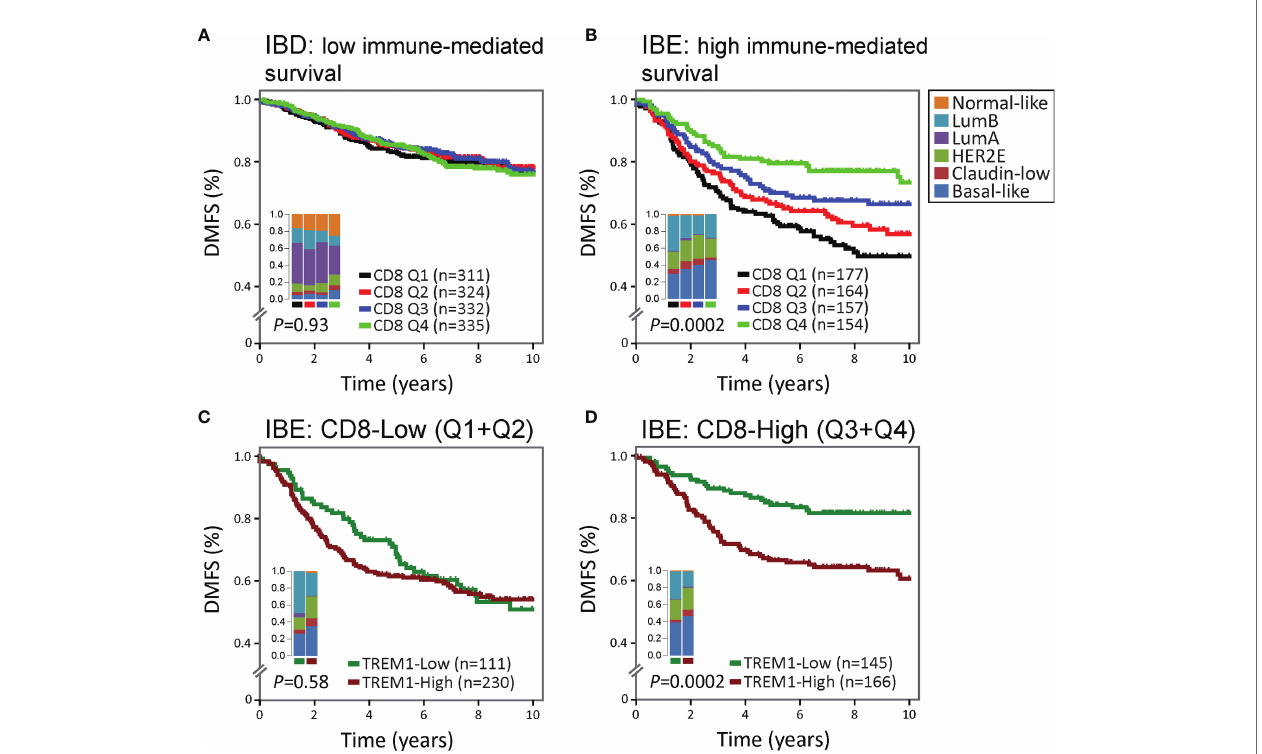
FIGURE 3 | The association between high TREM1 and increased metastatic risk is most signi fi cant in immunogenic tumors with DMFS-protective high CD8+ T cell in fi ltrates. The prognostic relevance of TREM1 expression was examined in (A) poorly immunogenic tumors of the MC1 cohort with low proliferative capacity [classi fi ed previously as immune bene fi t-disabled (IBD) (20)], and (B) moderate to highly immunogenic tumors of the MC1 cohort with high proliferative capacity [classi fi ed previously as immune bene fi t-enabled (IBE) (20)]. Patients were strati fi ed into DMFS survival curves based on the relative magnitude of tumor-in fi ltrating CD8+ T cells (CD8) estimated by the CIBERSORT algorithm (19). Q1, lowest CD8 quartile (black); Q2 and Q3, intermediate CD8 quartiles (red and blue); Q4, highest CD8 quartile (green). (C, D) Survival rates of patients with low (below-median) versus high (above-median) TREM1 expression were compared in the context of low versus high CD8+ T cell fraction estimates. The most signi fi cant difference was observed in IBE tumors. TREM1 expression level was not signi fi cantly associated with DMFS in IBE CD8-low tumors (C) , but showed marked signi fi cance in IBE CD8-high tumors (D) , where high TREM1 expression was signi fi cantly associated with increased risk of distant